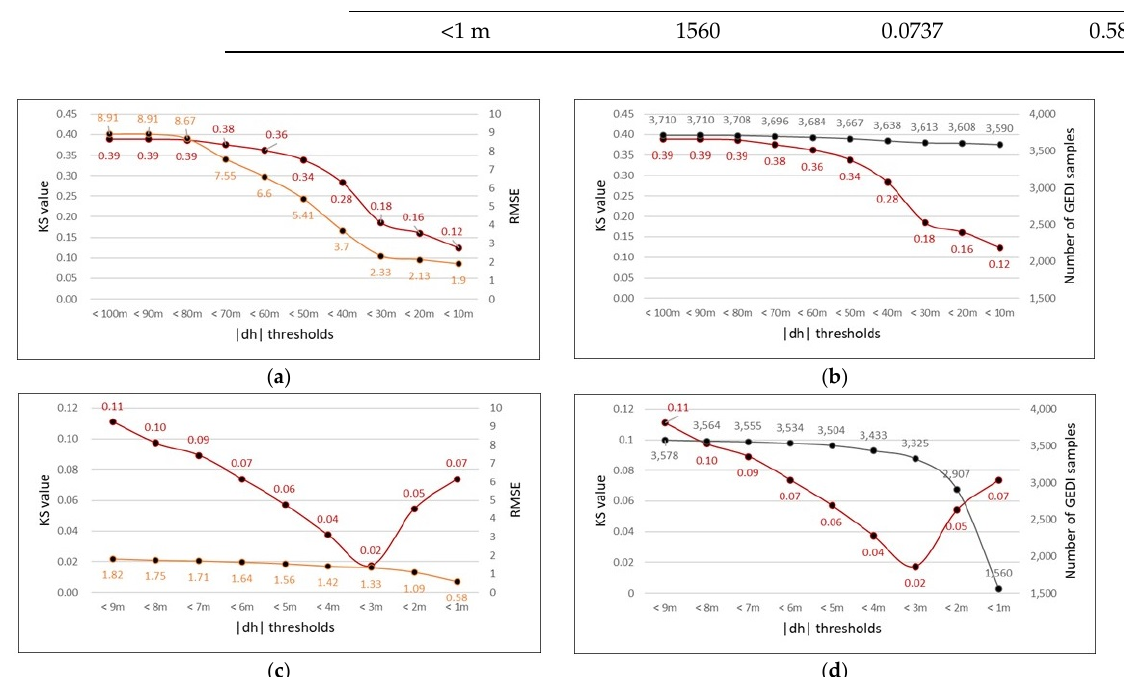
Figure 3. Comparison between calculated KS (red color), number of GEDI samples (grey color), and RMSE (orange color) curves from absolute dh-DTM thresholds. ( a ) Calculated KS and RMSE values—10 m interval from |dh| < 100 m and |dh| < 10 m; ( b ) calculated KS value and number of GEDI samples—10 m interval from |dh| < 100 m and |dh| < 10 m; ( c ) calculated KS and RMSE values—1 m interval from |dh| < 9 m and |dh| < 1 m; ( d ) calculated KS value and number of GEDI samples —1 m interval from |dh| < 9 m and |dh| < 1 m. Table 3. Statistics from pre-defined thresholds of absolute value of dh-DTM.